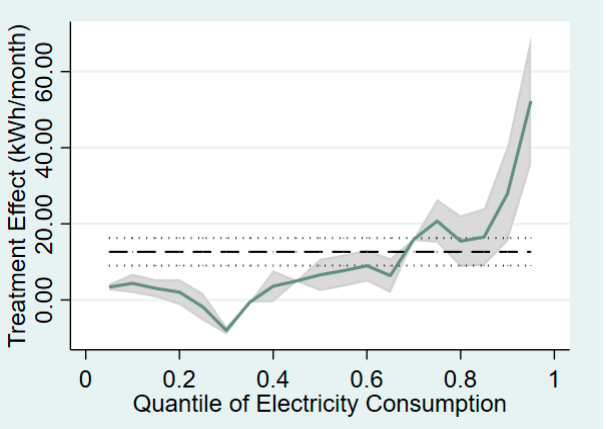
Figure 4. Treatment effect by the quantile of the monthly electricity consumption measured in kWh/month.